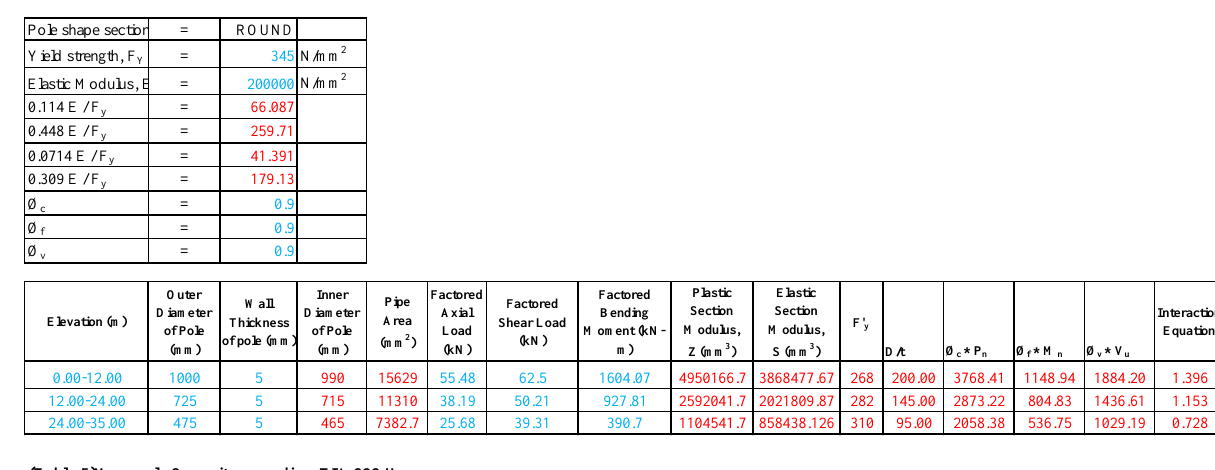
(Table-4)Monopole Capacity according TIA-222-H